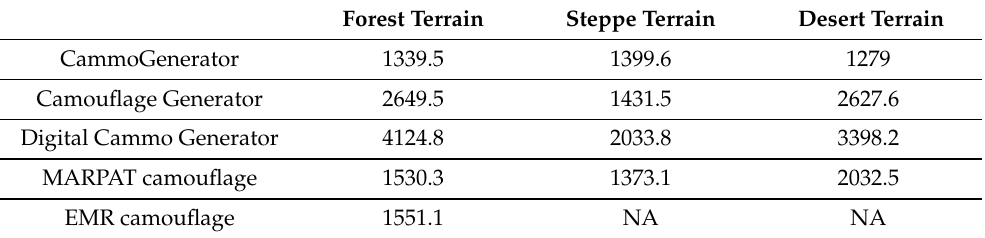
Table 1. Results of camouflage quality analysis for selected